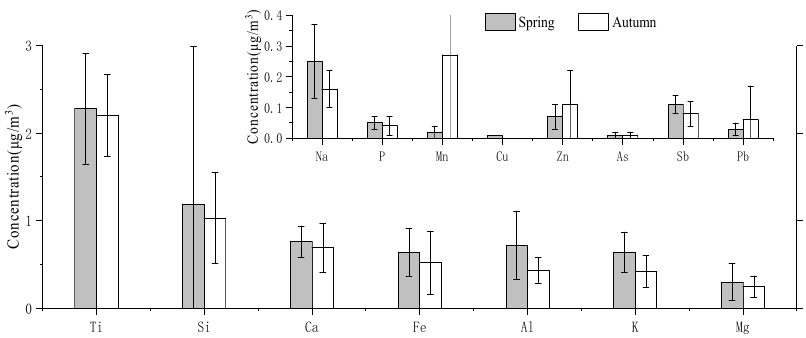
Figure 4. Mean concentrations of inorganic elements in PM 2.5 sampled at Wenshan.